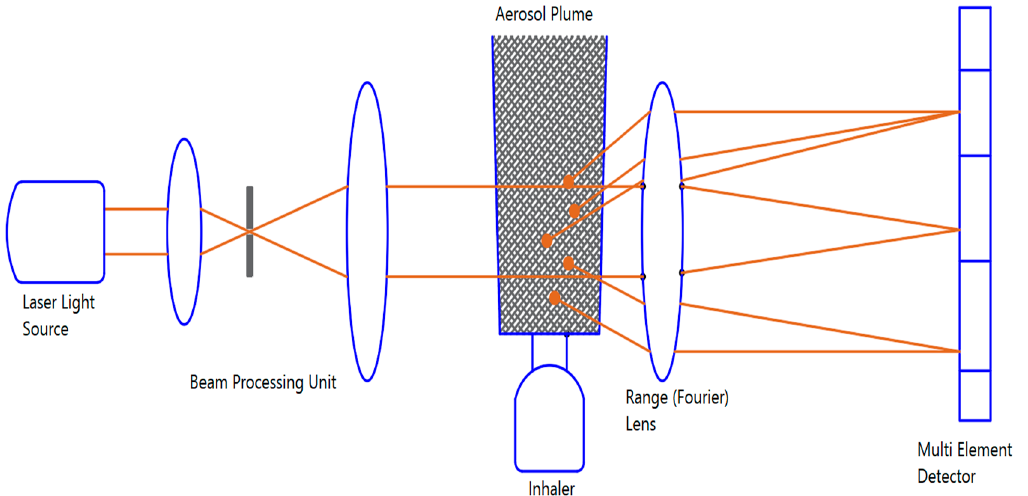
Figure 2. Schematic of a laser diffraction system described in a three step process. In the first step, coherent light is released from the laser diode. The light is then scattered through all the particles and the pattern is detected. Afterwards, the detected pattern is converted to a digital signal and then deconvoluted into droplet size distribution (DSD) [89].